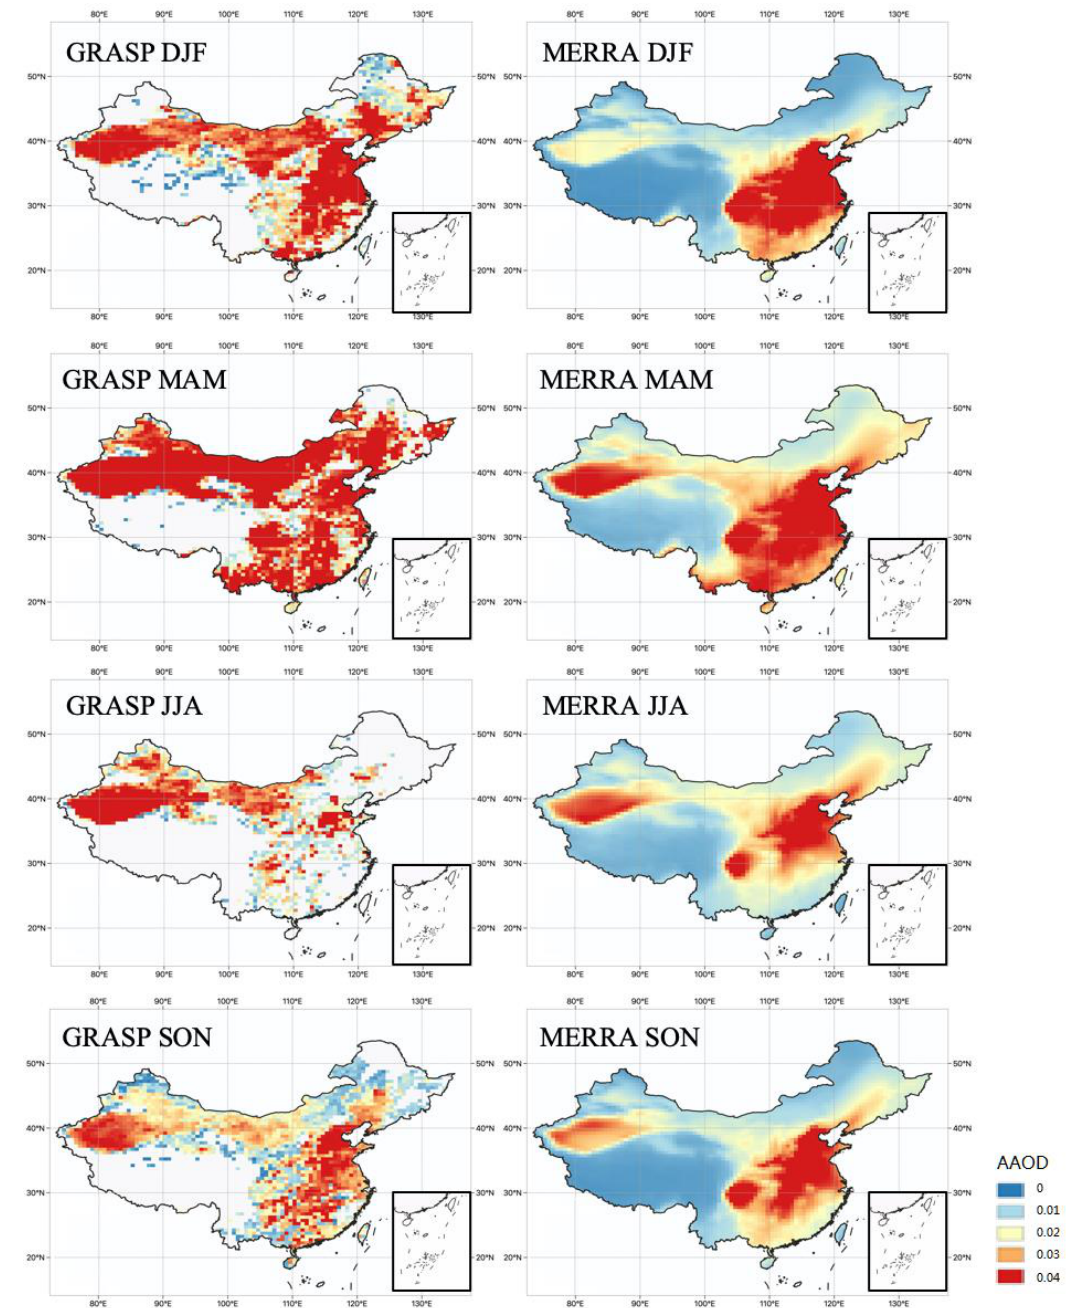
Figure 13. Same as Figure 9, but for